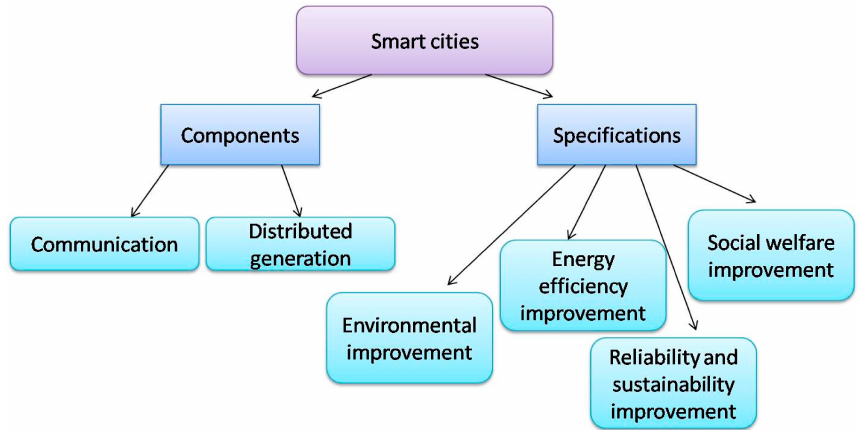
Figure 5. The aspects of a smart